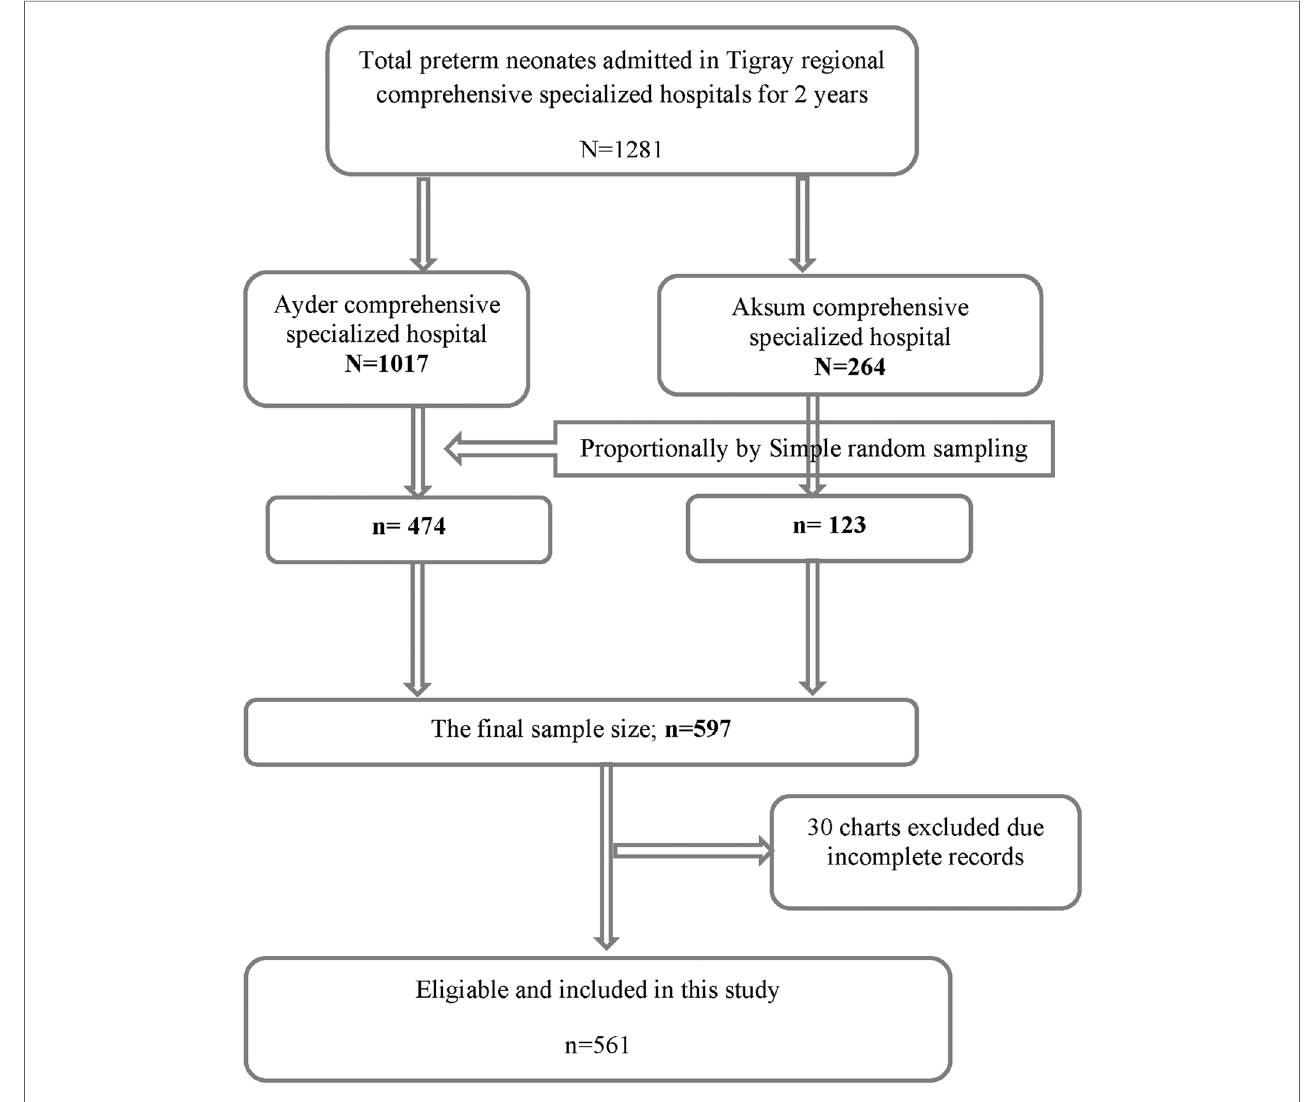
FIGURE 1 Flow diagram of study